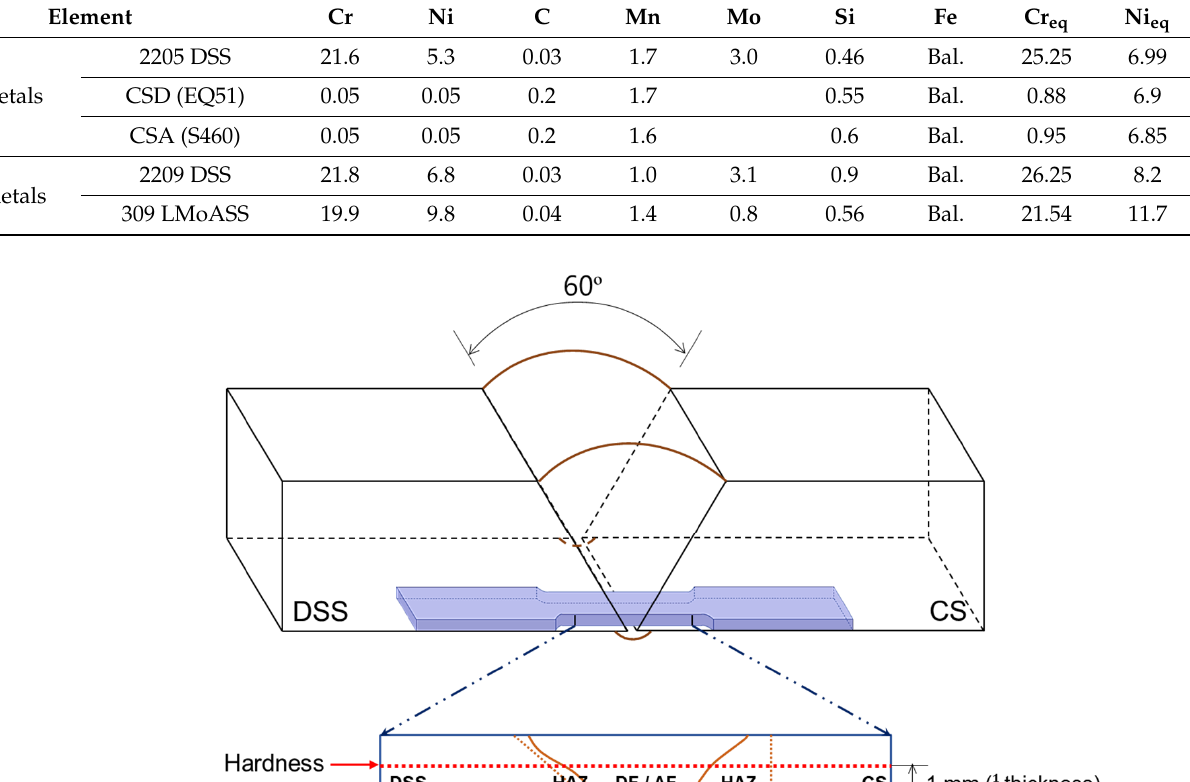
Table 2. Chemical compositions of the base and filler metals (wt.%).